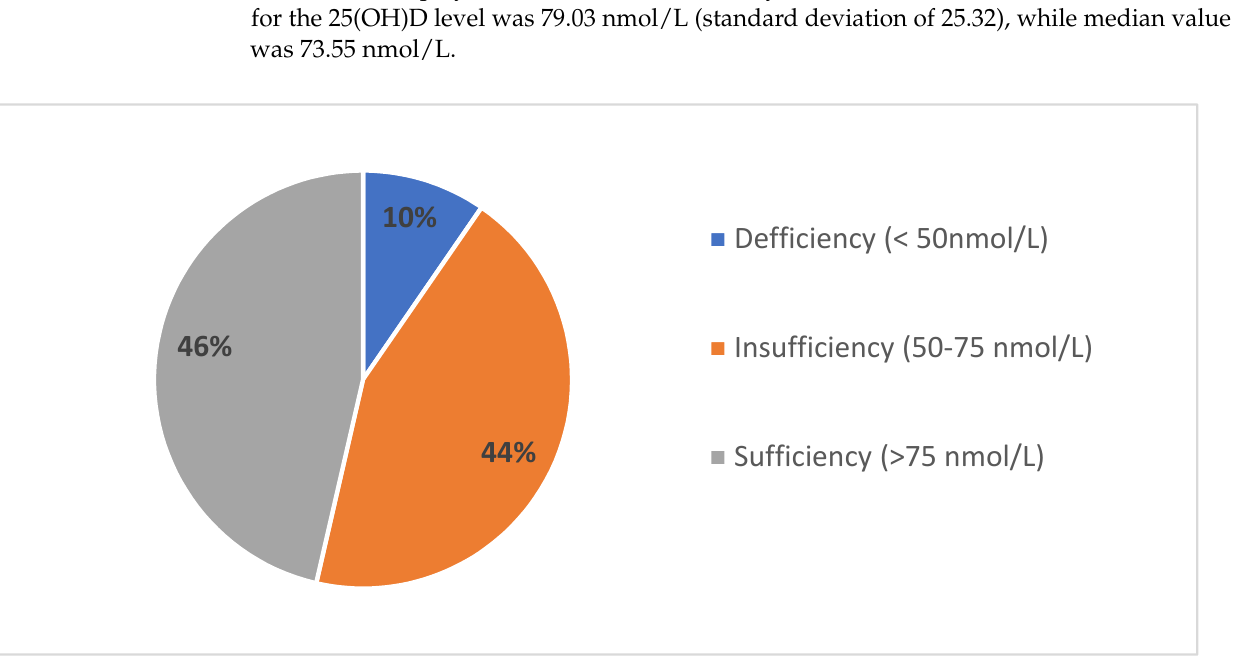
Table 1. Descriptive statistics and intra-testing reliability (ICC, CV) for the fitness tests and motor performance tests.